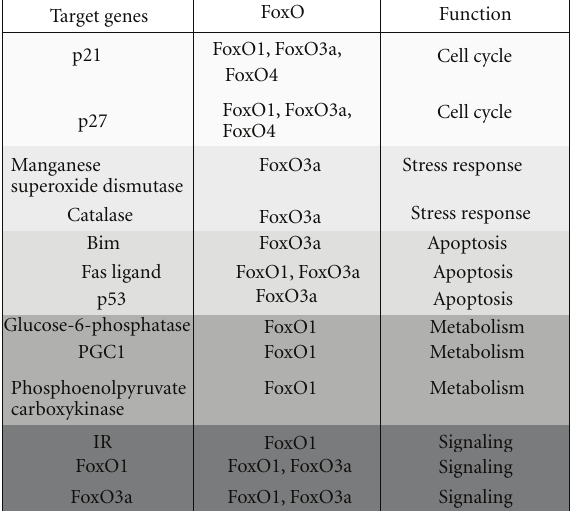
spatial expression pattern at least in the murine